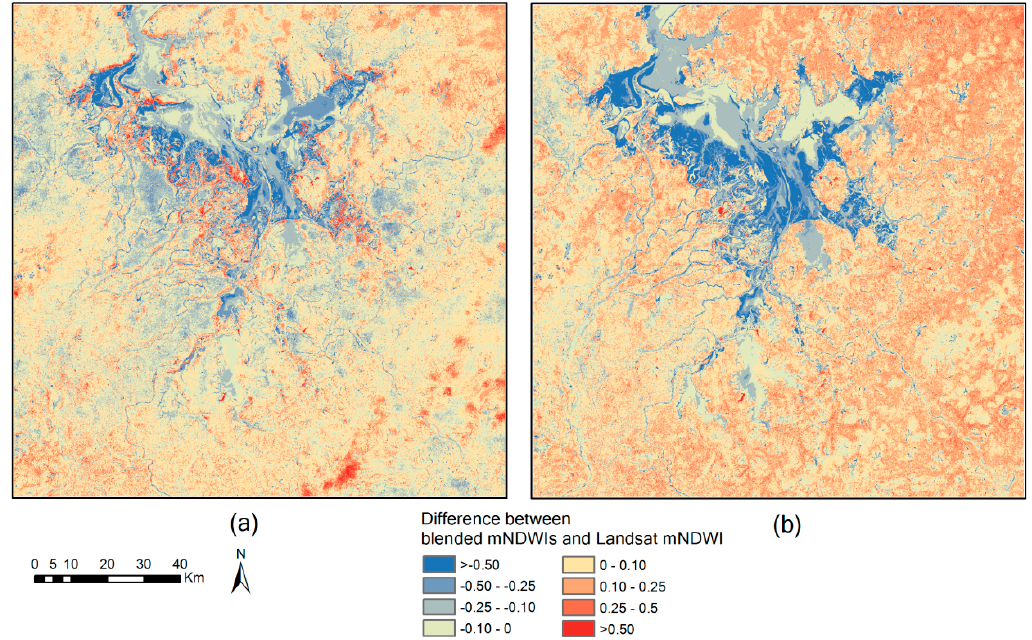
Figure 6. ( a ) Difference between IB derived mNDWI and Landsat mNDWI; ( b ) difference between BI derived mNDWI and Landsat mNDWI.